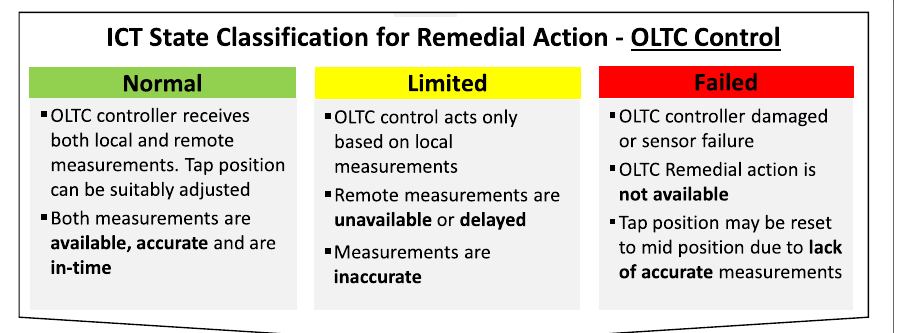
Fig. 6 ICT State Classification of Remedial Action - OLTC